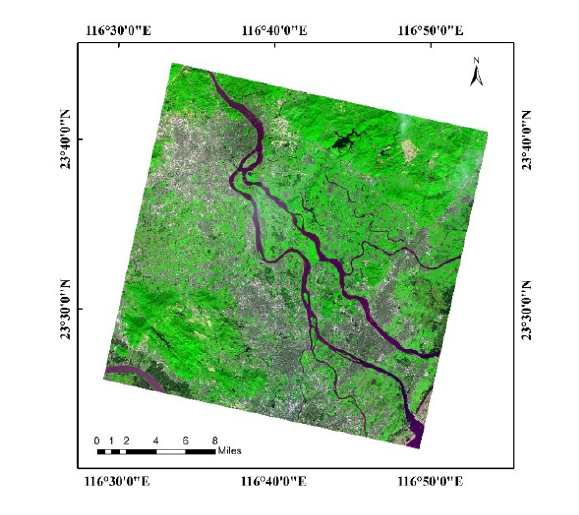
Figure 2. Schematic diagram of integrated